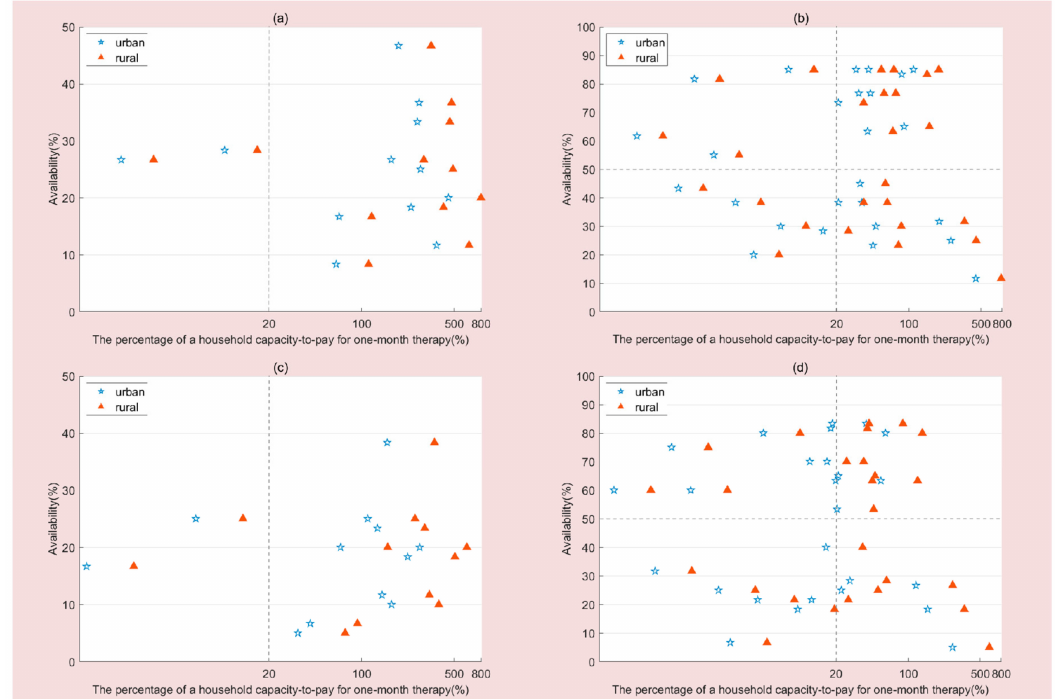
Figure 1. Comprehensive analysis of medicine availability and a ff ordability. ( a ) Comprehensive analysis of OBs availability and a ff ordability in 2012. ( b ) Comprehensive analysis of LPGs availability and a ff ordability in 2012. ( c ) Comprehensive analysis of OBs availability and a ff ordability in 2016. ( d ) Comprehensive analysis of LPGs availability and a ff ordability in